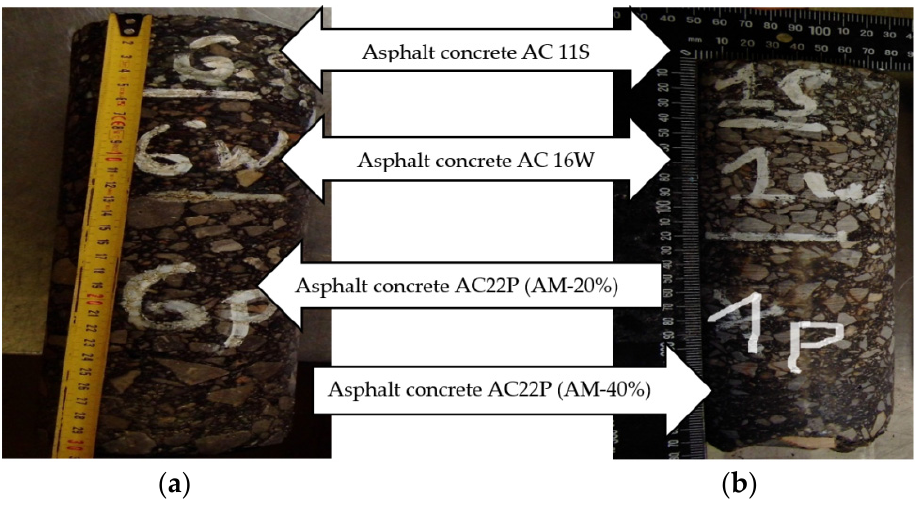
Figure 5. Extracted pavement cores: ( a ) AM-20% and ( b ) AM-40%.